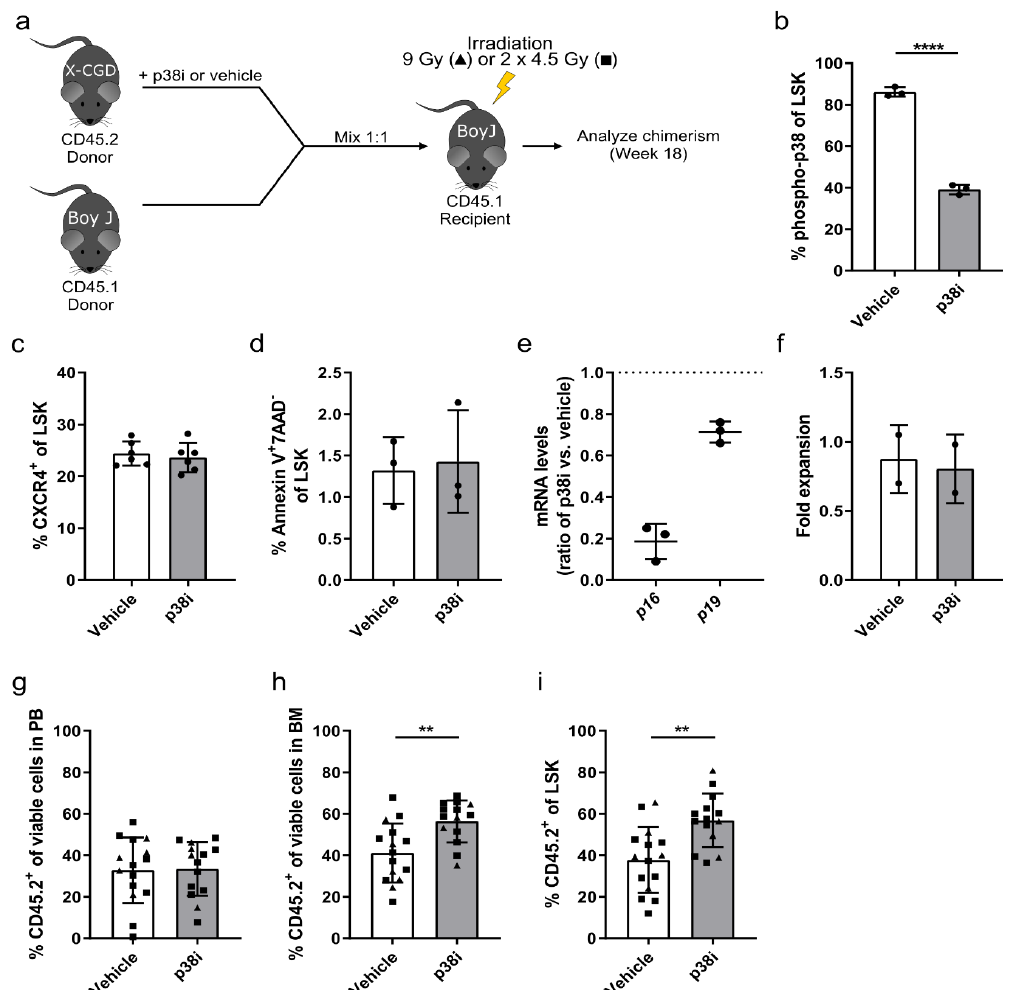
Figure 5. Inhibition of p38 MAPK improves the engraftment of HSPCs derived from the X-CGD mouse model. ( a ) Schemata of competitive bone marrow transplantation of X-CGD HSPCs.